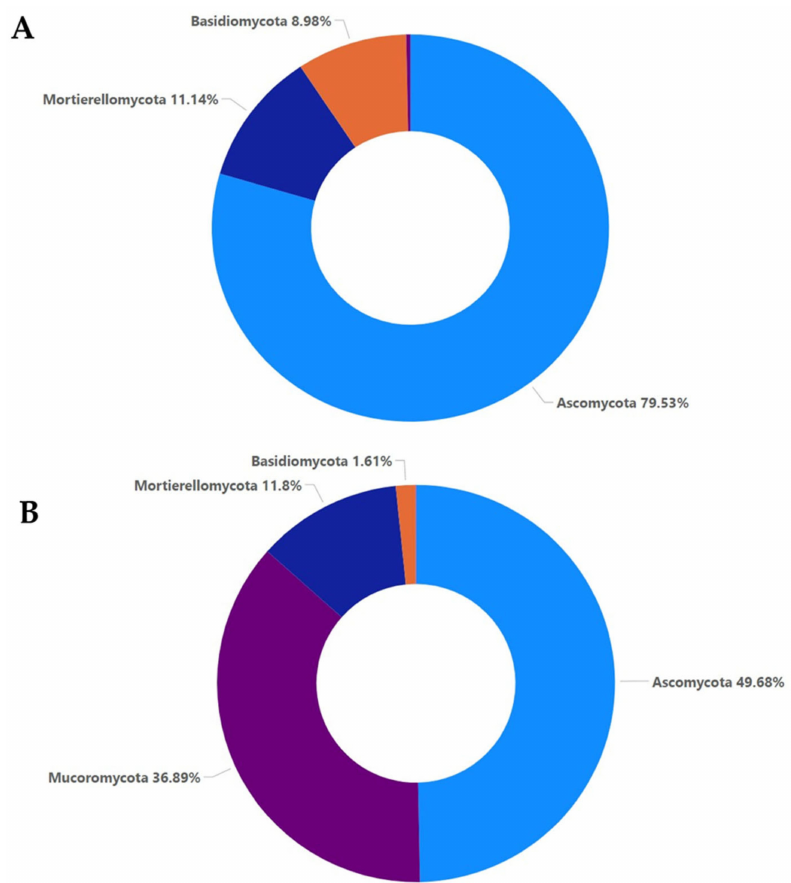
Figure 1. Relative abundance with percentages above 1% for the phylum taxa, as shown for the non-inoculated samples ( A ) and inoculated samples ( B ).